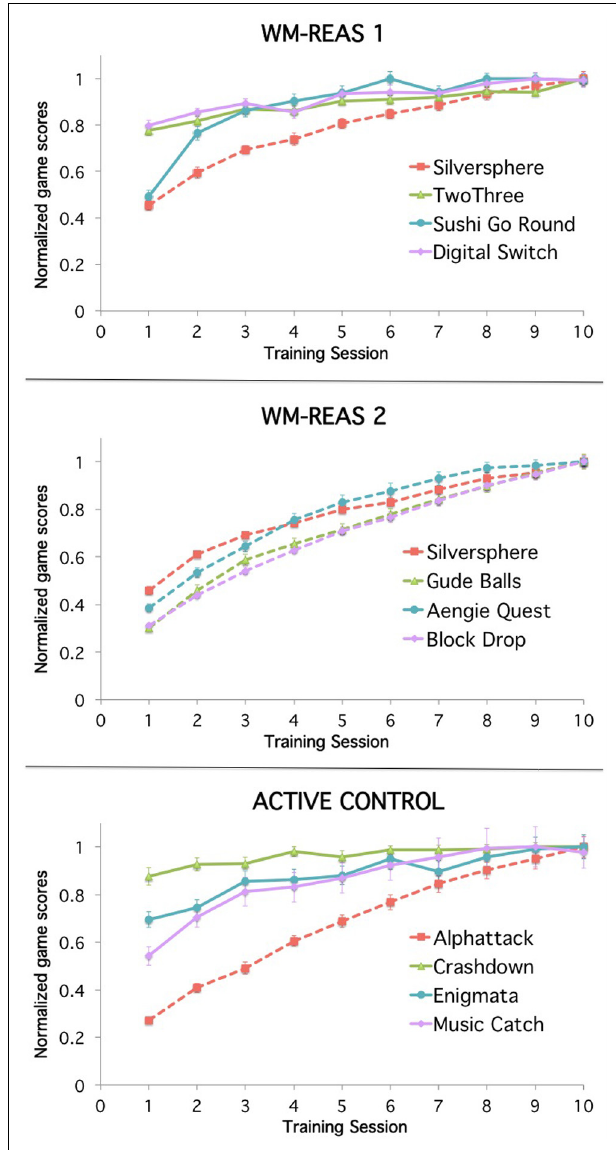
FIGURE 1 | Mean training game performance as a function of group and session. Group average scores at each session, normalized by each game’s maximum average score:WM-REAS 1: Silversphere = 18.861, TwoThree = 20.265, Sushi-Go-Round = 5785.429, Digital Switch = 8.161; WM-REAS 2: Silversphere = 19.421, Gude Balls = 14.474, Aengie Quest = 20.526, Block Drop = 52.385; Active Control: Alphattack = 51.867, Music Catch = 4032358.24, Crashdown = 6.667, Enigmata = 4.069. Dashed lines indicate games that were adaptive across sessions. Error bars represent ±